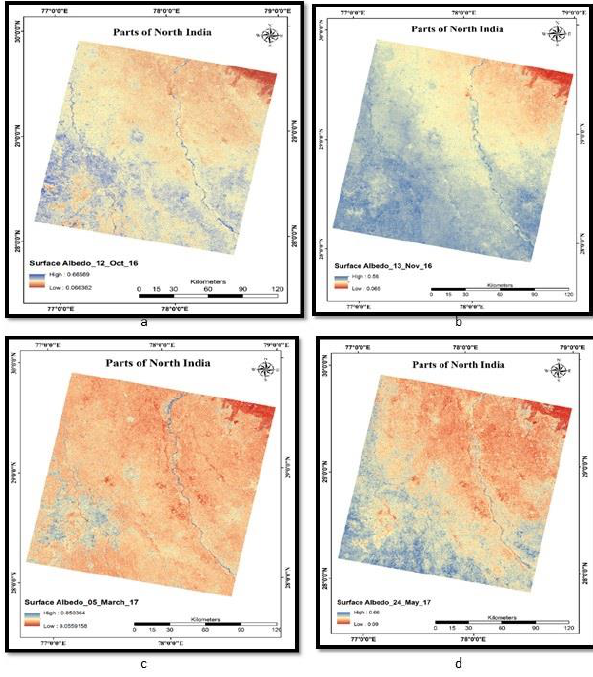
Figure 4. Surface Albedo a) 12/10/2016; b)